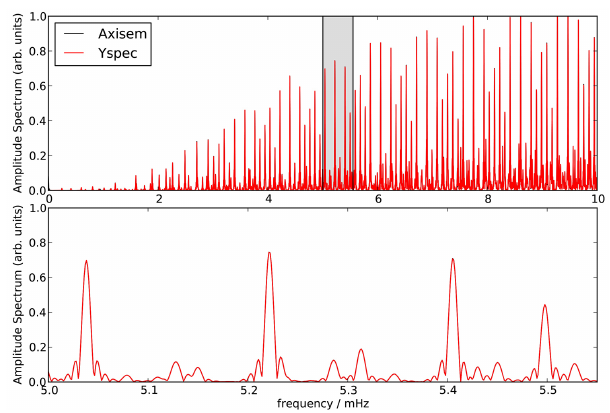
Figure 12. Amplitude spectra simulated by AxiSEM and YSpec for the PREM model (Dziewonski and Anderson, 1981) for frequencies below 0.02 mHz. The time-domain solution provided by AxiSEM extended over 48h time series using 1.7 Million time steps. While amplitude spectra do not exhibit issues related to numerical disper- sion, the fit between these two different methods is remarkable.